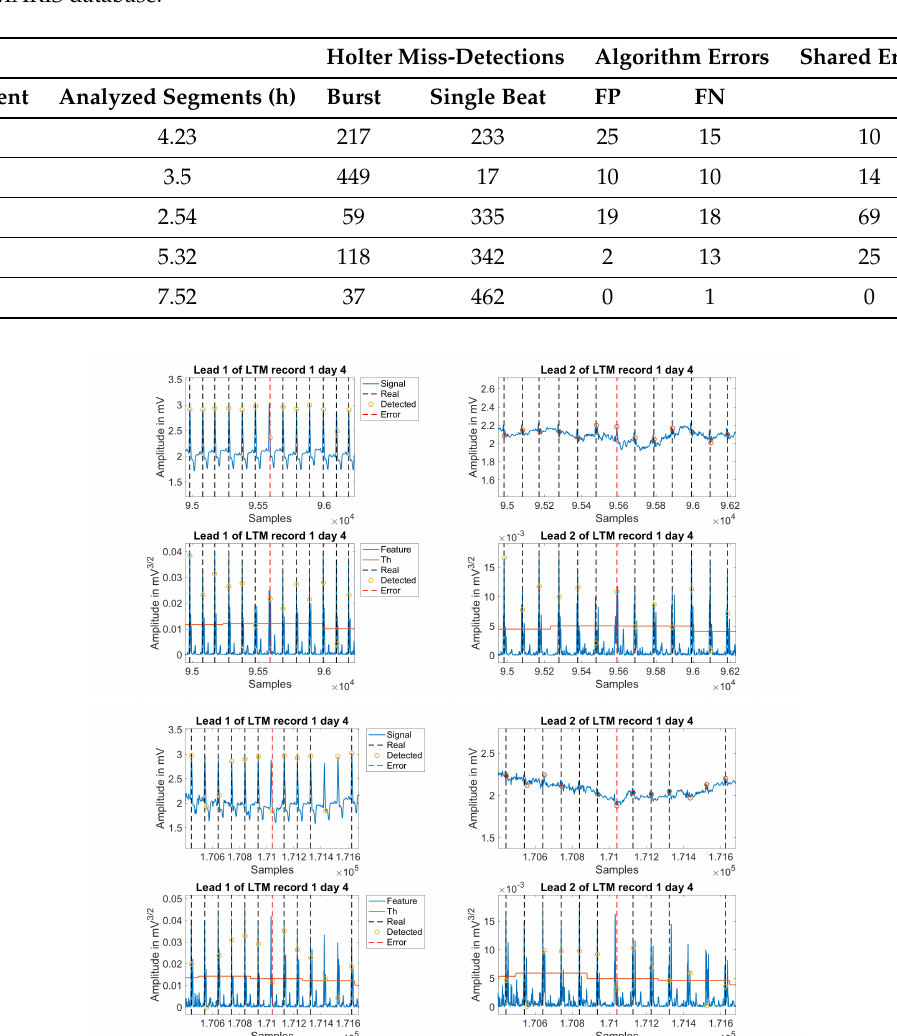
Figure 9. Example of single beat miss-detection in conventional Holter LTM. The panels in the first row show leads 1 and 2 for an example of Holter miss-detection, the second row shows the feature signal for the leads plotted before. The last four panels follow the same scheme for other Holter miss-detection